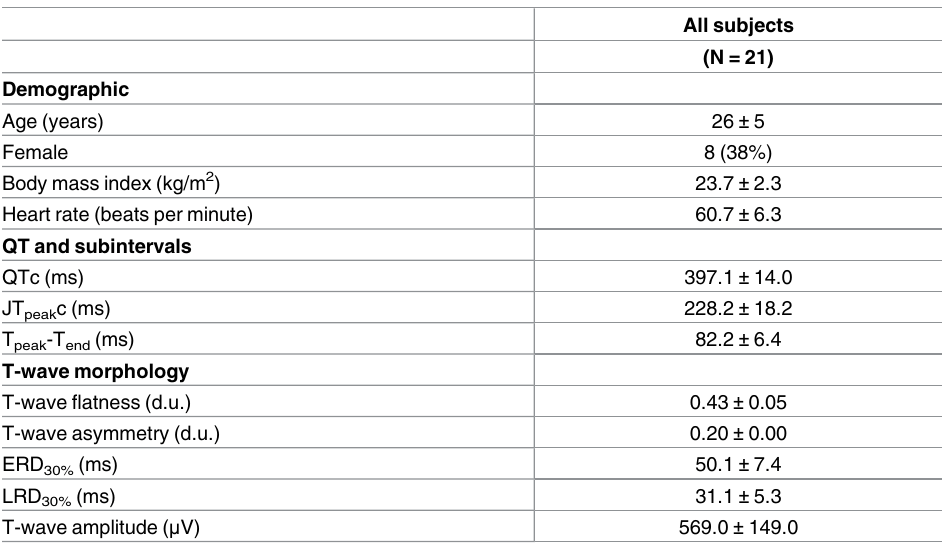
Table 1. Baseline